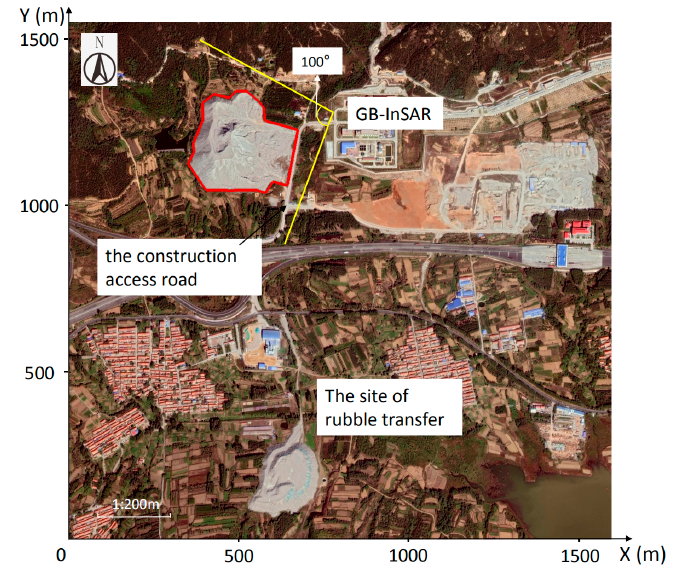
Figure 3. Relative position of project site (adapted from google maps). Where GB-InSAR is ground-based interferometric synthetic aperture radar.